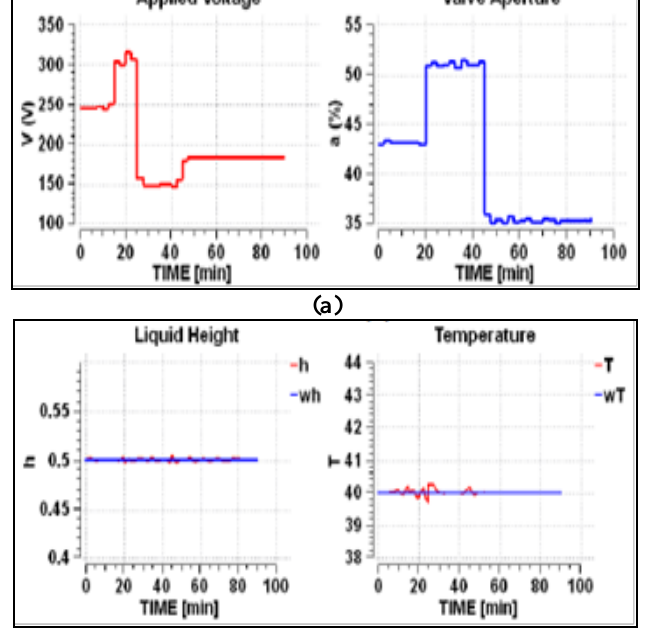
Figure 6: (a) Manipulated and (b) controlled variables, Source: Authors, (2018).